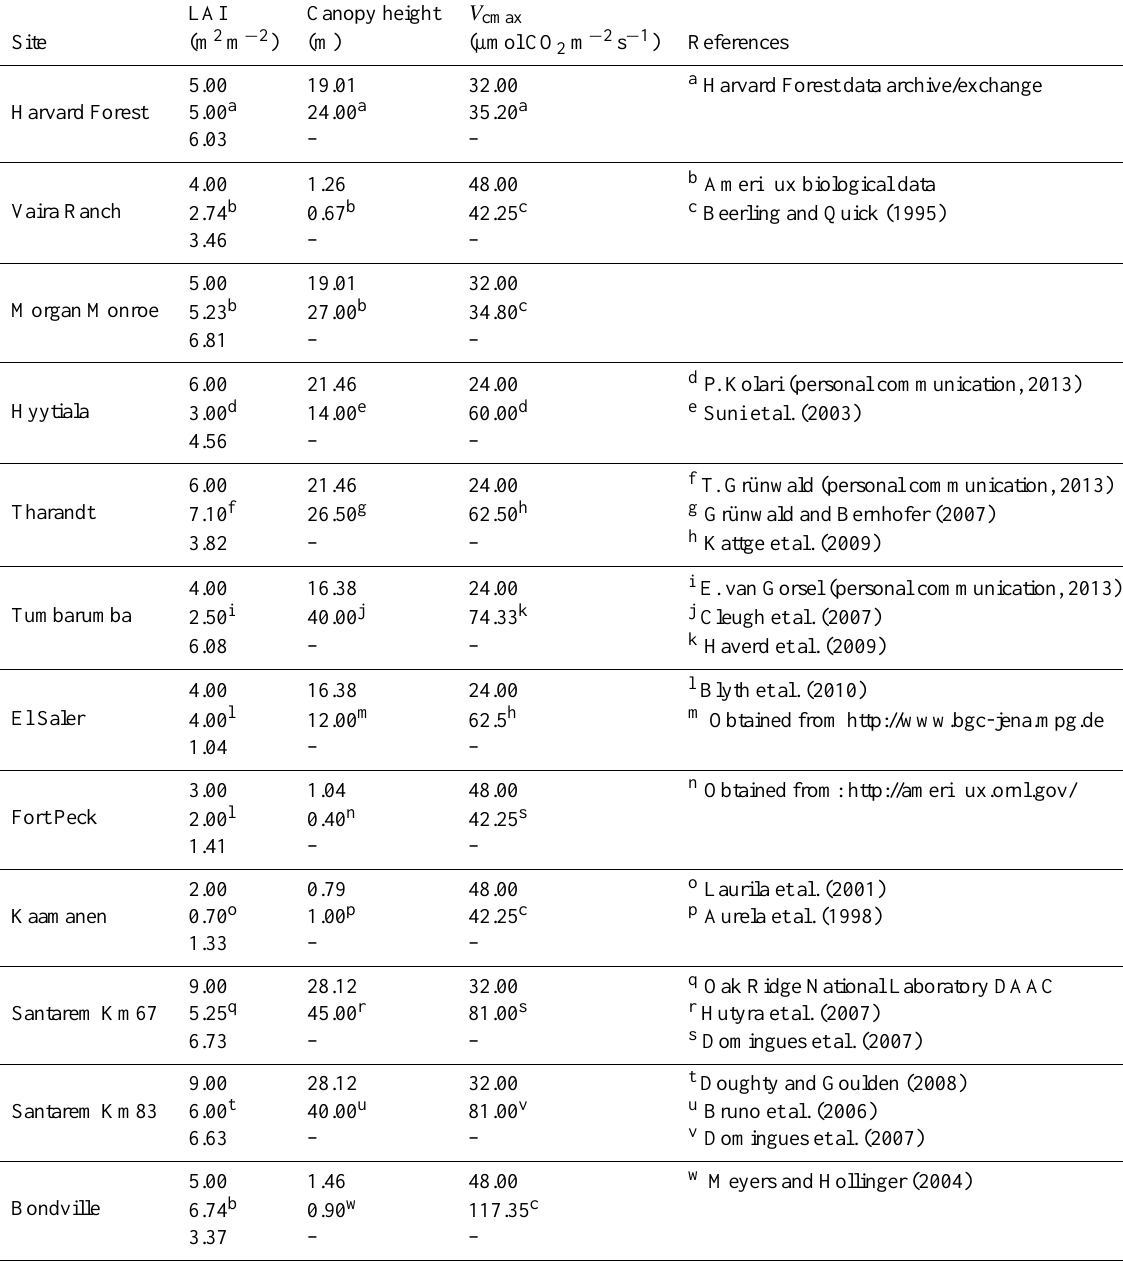
Table 6. Local and global biophysical parameters (site annual maximum LAI, canopy height and V cmax ) at the 12 FLUXNET sites. For each site, the first row refers to global data, the second refers to local and the third refers to satellite. Online data was accessed in April 2013. LAI Canopy height V